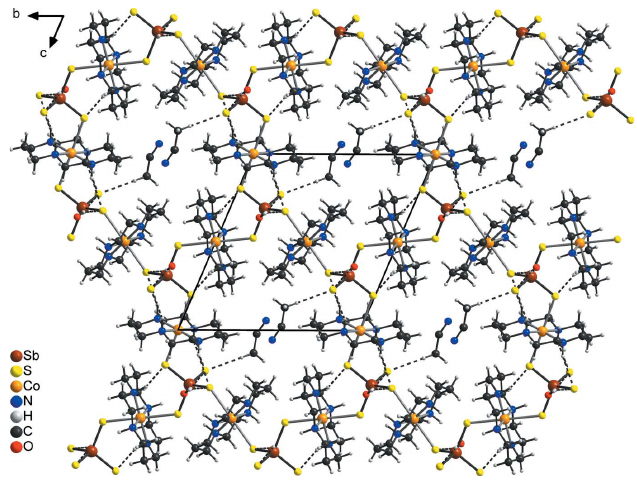
Figure 5 Crystal structure of the title compound with a view in the a -axis direction with intermolecular hydrogen bonding shown as dashed lines. The disorder of the acetonitrile molecules is omitted for clarity.